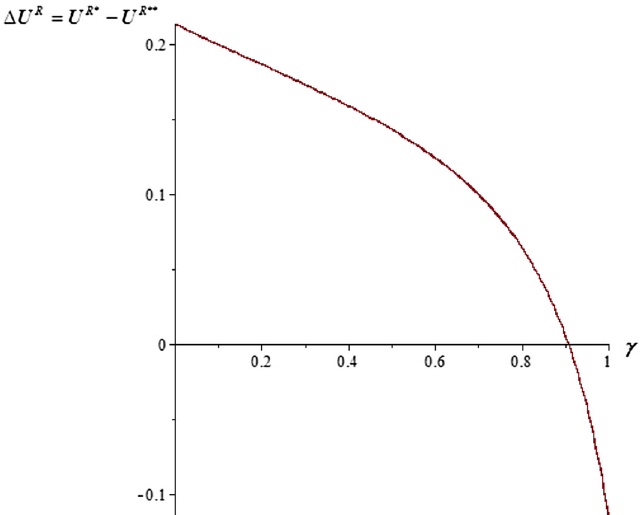
Fig. 3 Optimality of both accounting systems depending on c under limited commitment. Parameters of the example: r ¼ 1 ; r ¼ 2 ; v ¼ 5 ; k ¼ 0 :